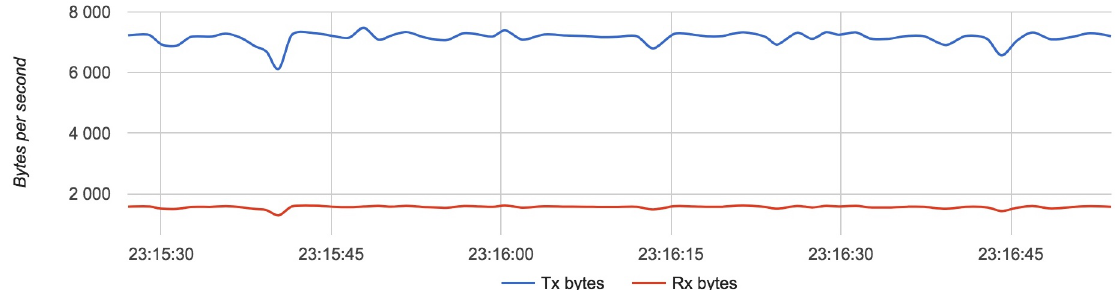
Figure 20. Bandwidth usage for a drone with Configuration 3.